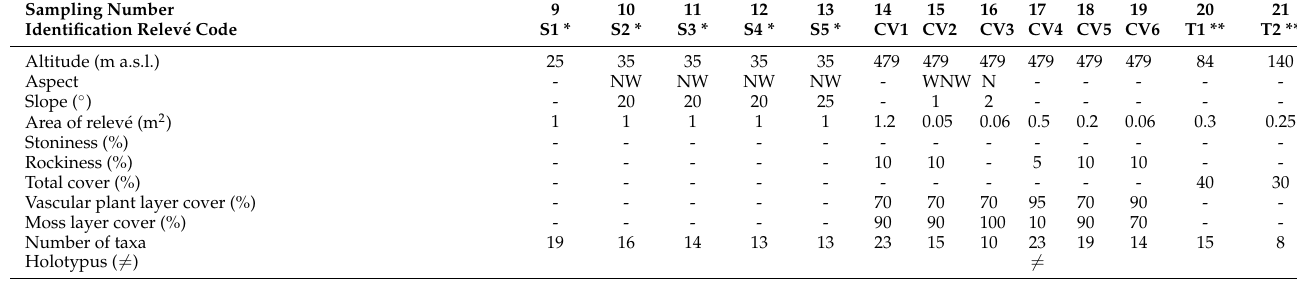
Table 2. Rumici bucephalophori-Ophioglossetum lusitanici and trifolietosum scabri subass. nova hoc loco. Further details of relev é s and sporadic species are reported in Appendices A and B,